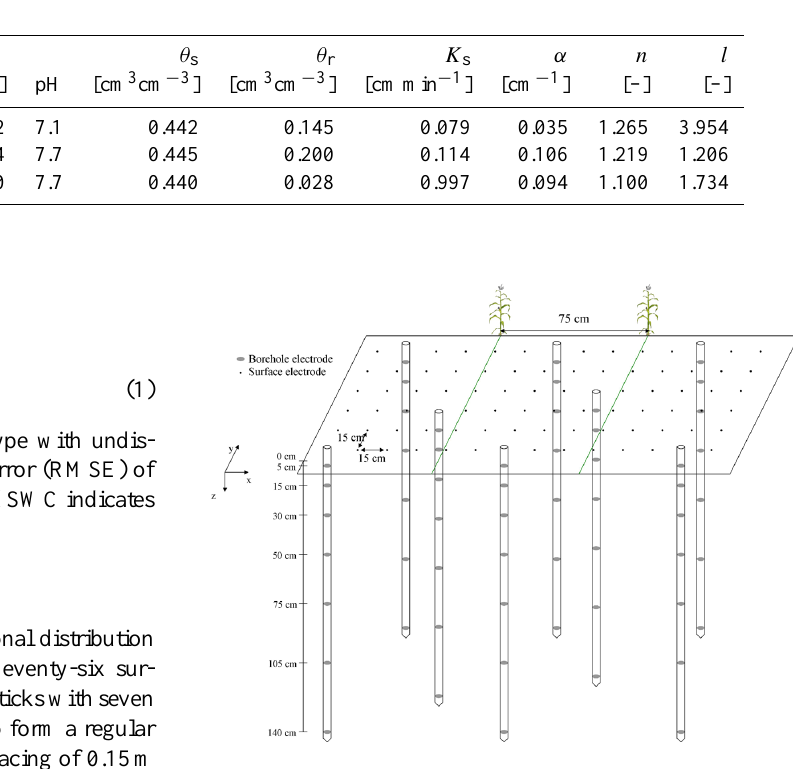
Fig. 3. Scheme of the ERT electrode positions. The tubes with black rings represent the PVC sticks with the ring electrodes; the black dots represent the surface electrodes. The green lines correspond to the maize